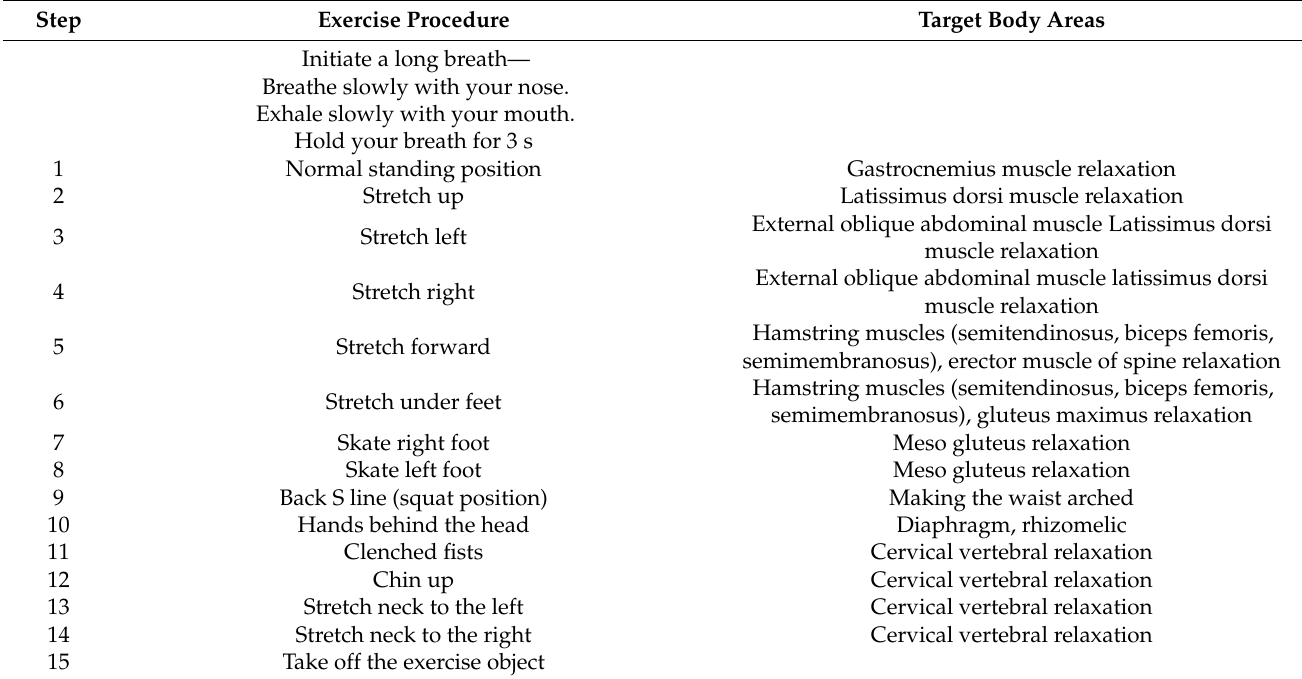
Table 12. Revised exercise program procedure and the targeted areas of the